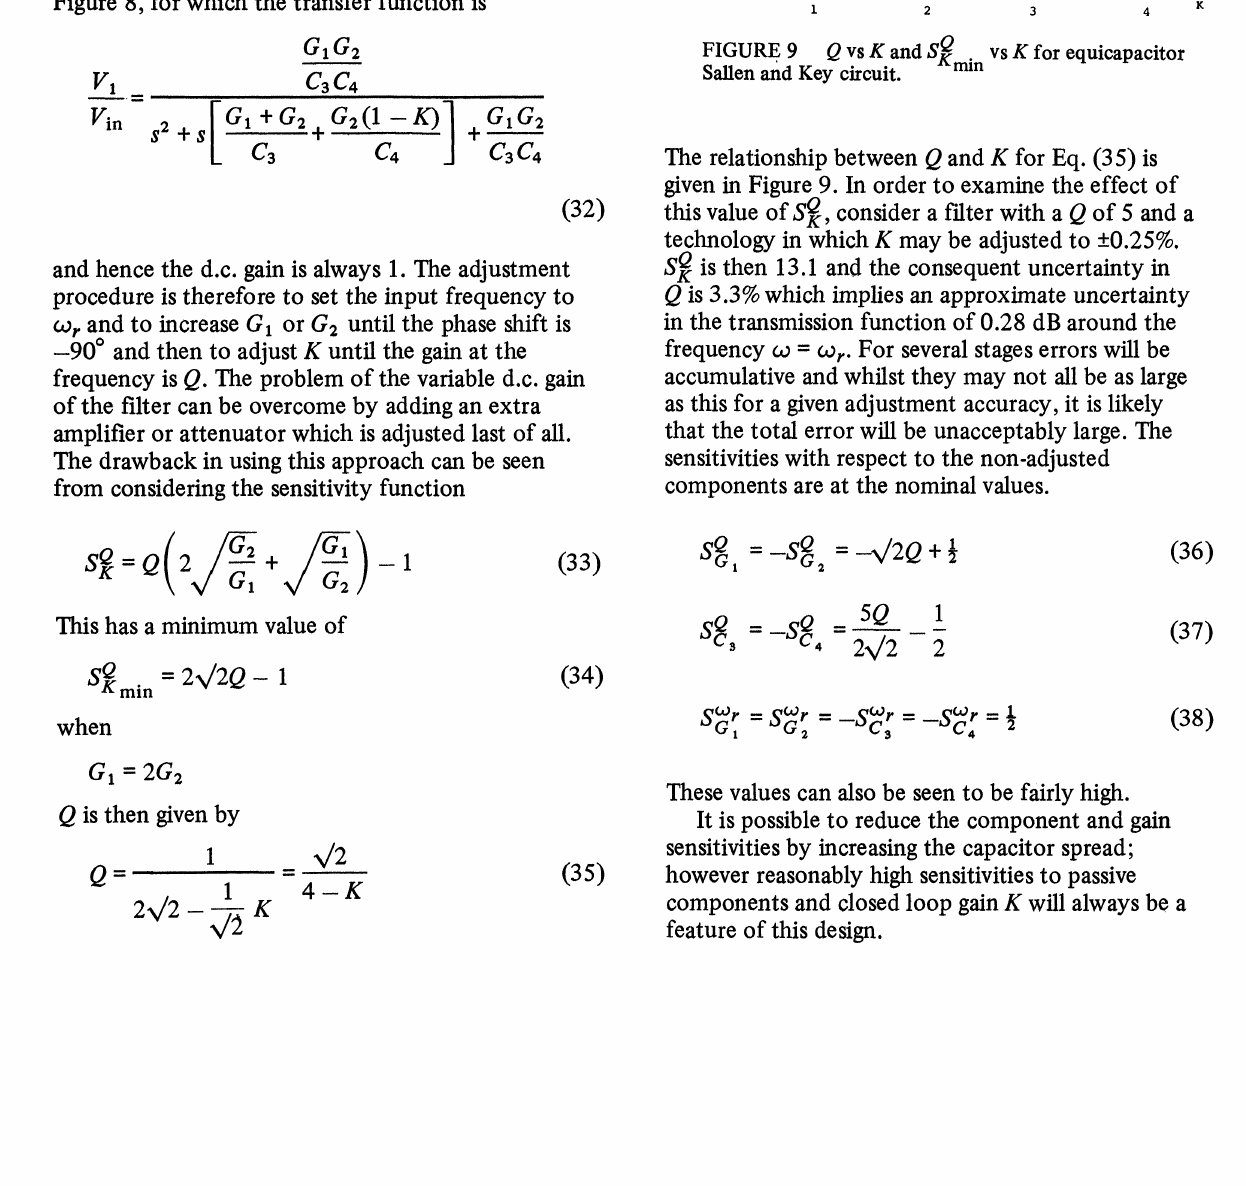
FIGURE 9 Q vs K and S Q vs K for equicapacitor Sallen and Key ckcuit.